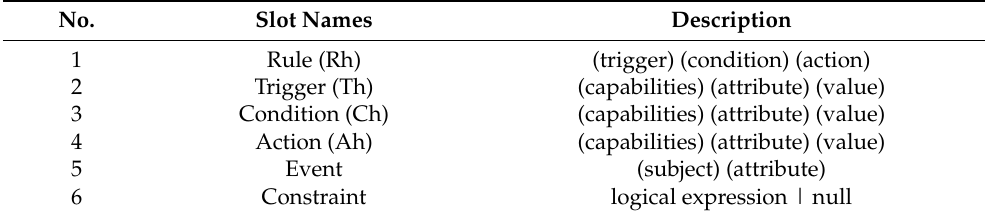
Table 2. Rule representation